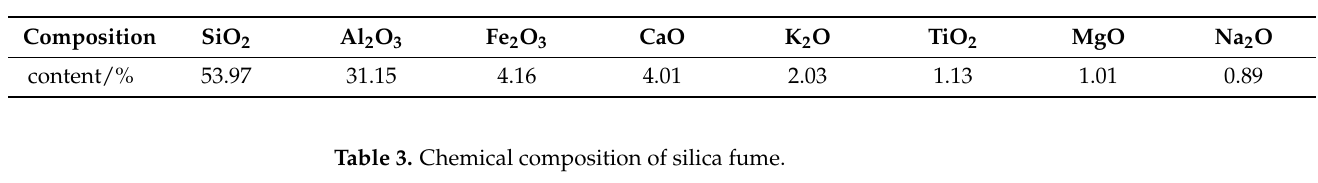
Table 2. Chemical composition of fly ash.